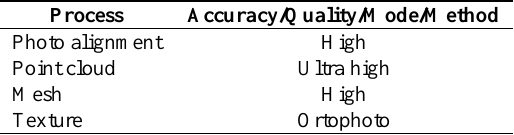
Table 1. Preferred work standards in image processing